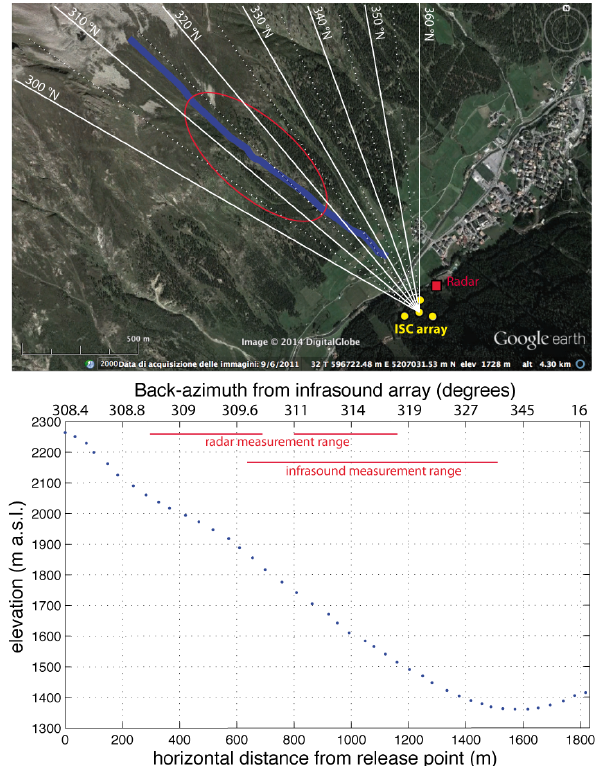
Figure 4. Upper panel: view of the Grosstal avalanche path (blue) showing the theoretical values of back azimuth to the array (white) and target area of the Doppler radar (red). Lower panel: the Grosstal avalanche path as a function of infrasonic back azimuth to the array and horizontal distance from release